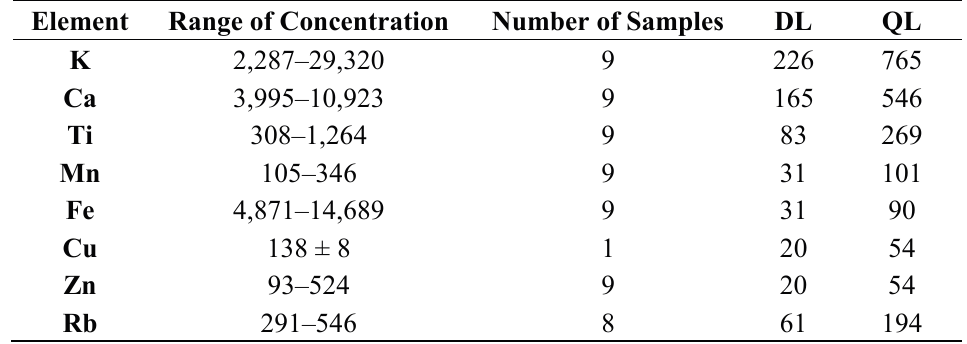
Table 2. Range of concentration for eye shadows with the respective detection limit (DL) and quantification limit (QL). Values in mg·kg − 1